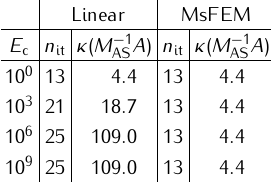
Table 2. Iteration numbers n and condition numbers κ ( M − 1 A ) for Experiment 1; geometry: 1 /h× 1 /h×H/h , h = 1 / 240 , H = 12 h ; linear and it AS multiscale coarsening for different contrasts E